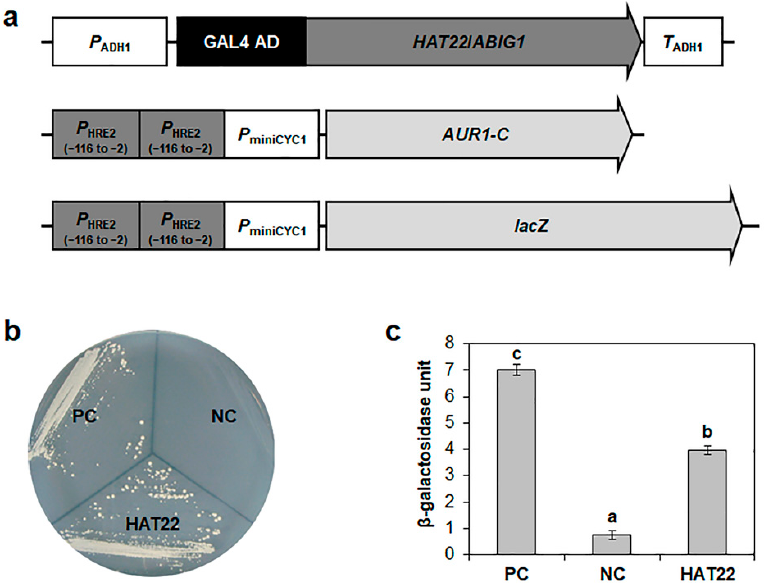
Figure 5. Confirmation of binding of HAT22/ABIG1 to HRE2 promoter. ( a ) Schematic maps of vectors for yeast one-hybrid assay. AUR1-C and lacZ reporter genes were used for yeast one-hybrid assay. ( b ) Yeast growth assay. Yeast transformants were grown on SM-Leu/-Ura containing 150 ng/mL Aureobasidin A (AbA). ( c ) Quantitative β -galactosidase orthonitrophenyl- β -D-galactopyronoside (ONPG) assay. β -Galactosidase activities were used for binding activity quantification. The data are shown as means ± S.D. ( n = 3). Different letters display significant differences ( p < 0.05). In ( b , c ), GCC box and empty vectors were used for positive and negative controls, respectively. PC, positive control; NC, negative control.